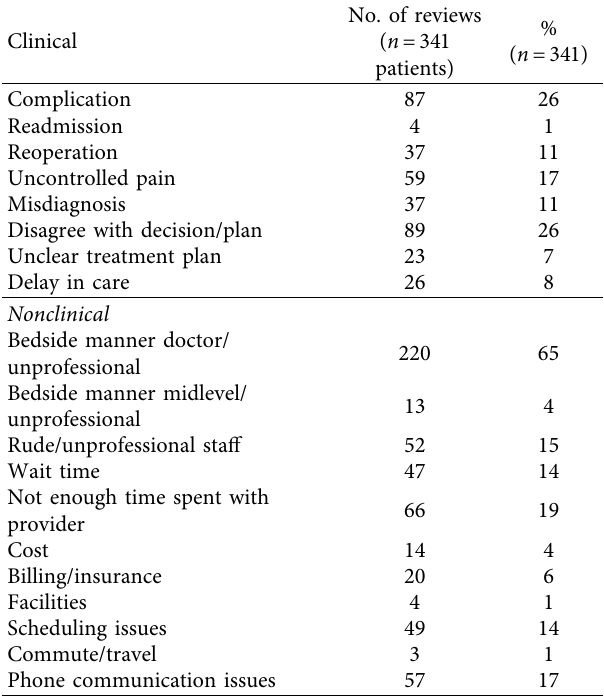
Table 3: One-star reviews of orthopedic oncology surgeons.